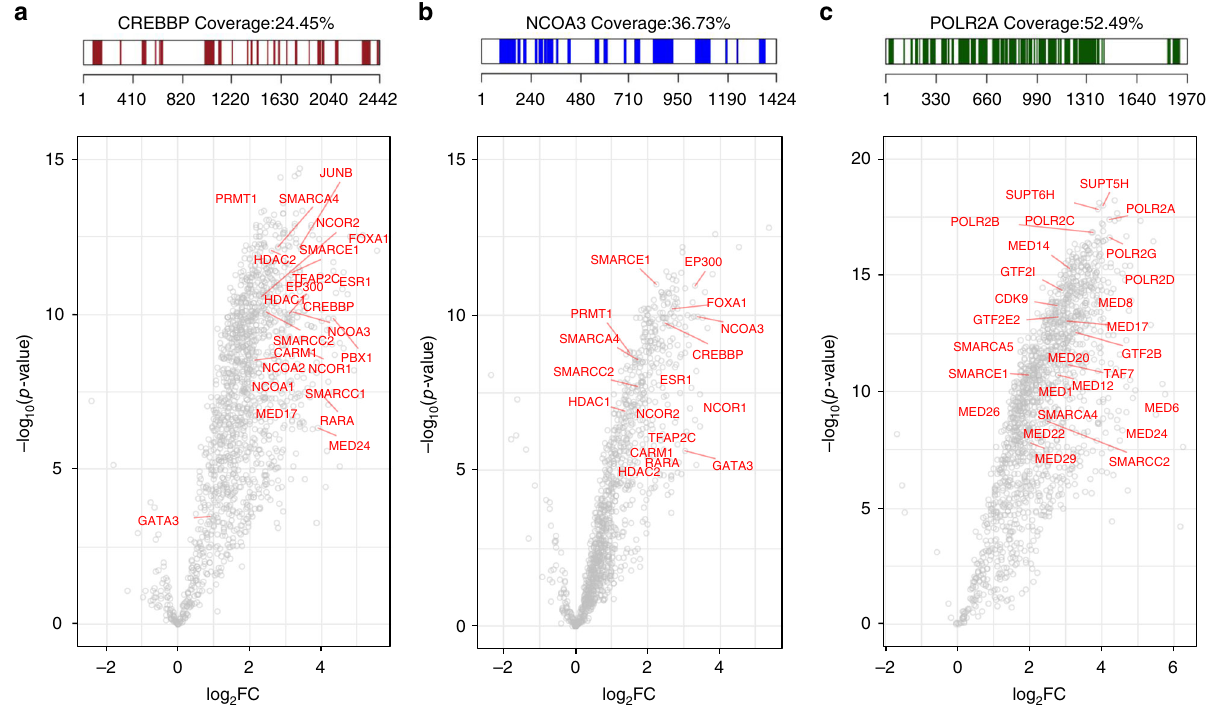
Fig. 3 Application of qPLEX-RIME in CREBBP, NCOA3 and POLR2A. a Peptide sequence coverage of the CREBBP (CBP) protein in the qPLEX-RIME analysis (top panel). The volcano plot summarises the quantitative results of the CBP qPLEX-RIME and several of its known interactors are highlighted in red font (bottom panel). b Peptide sequence coverage of the NCOA3 protein in the qPLEX-RIME analysis (top panel). The volcano plot summarises the quantitative results of the NCOA3 qPLEX-RIME and several of its known interactors are highlighted in red font (bottom panel). c Peptide sequence coverage of the phospho-polymerase II (POLR2A) protein in the qPLEX-RIME analysis (top panel). The volcano plot summarises the quantitative results of the POLR2A qPLEX-RIME and several of its known interactors are highlighted in red font (bottom